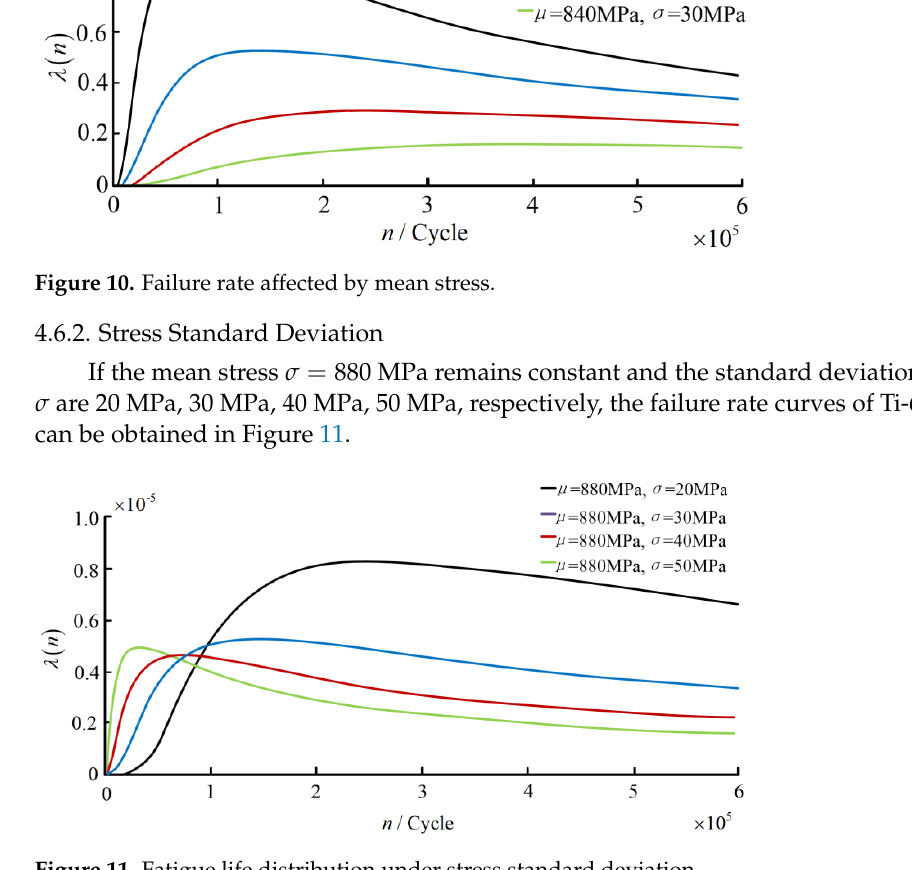
Figure 11. Fatigue life distribution under stress standard deviation.